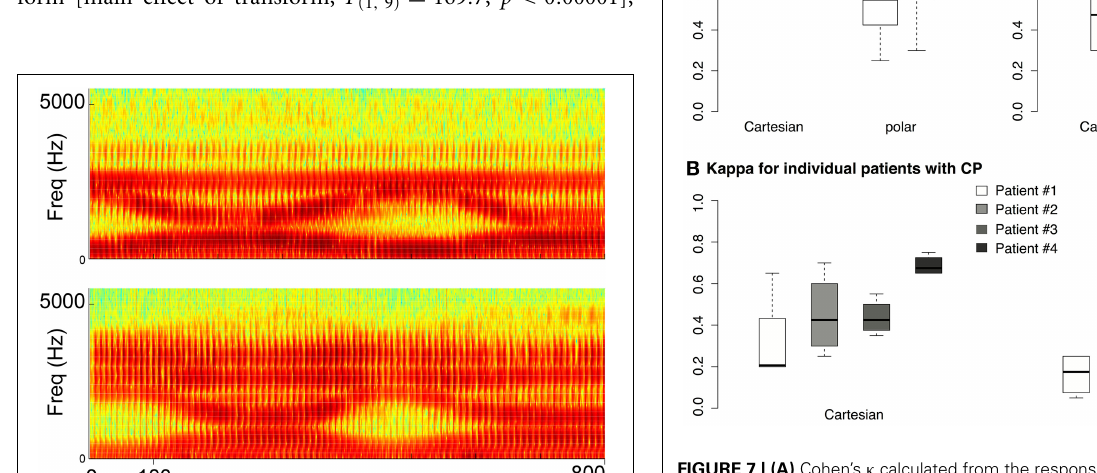
FIGURE 7 | (A) Cohen’s κ calculated from the responses of 4 listeners for the 10 healthy subjects. Each data point represents the responses from 1 listener across 25 vowels. For healthy subjects, each box covers 4 (listener) × 10 (subject) = 40 data points. (B) Cohen’s κ calculated from the responses of 4 listeners for 4 patients with CP, each box covers 4 (listener) × 4 (patient) = 16 data